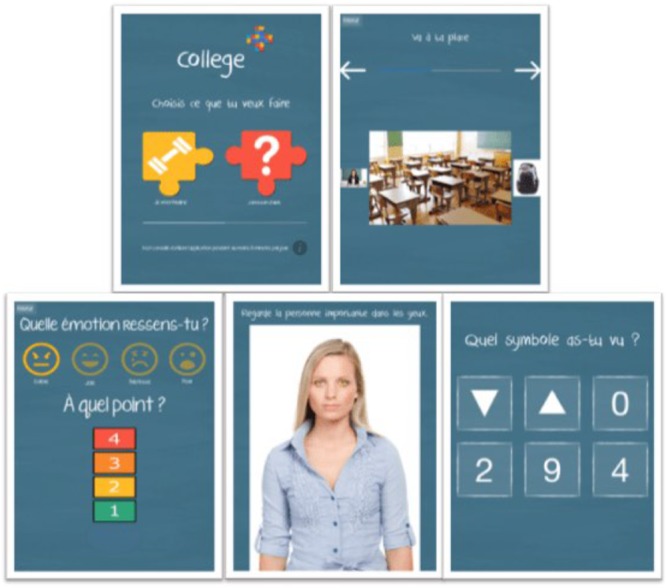
School+ package (“Make your choice”; “Training”; “Assistance”).